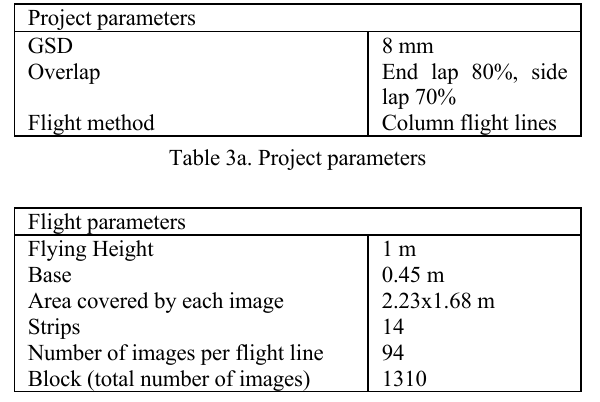
Table 3b. Flight parameters